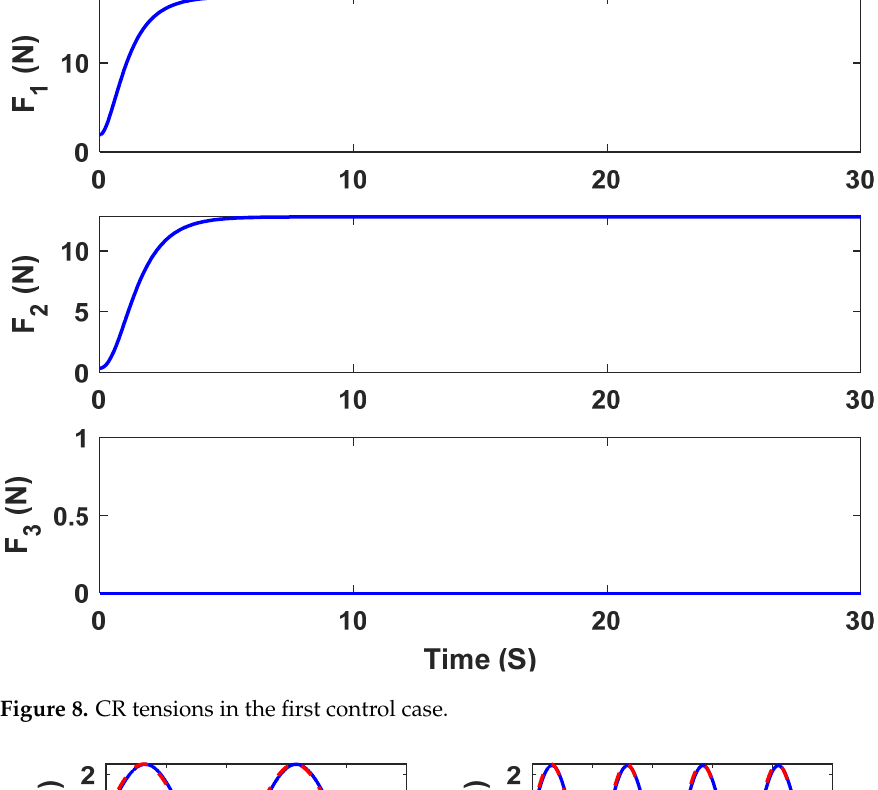
Figure 7. UAV motors thrusts in the first control case.